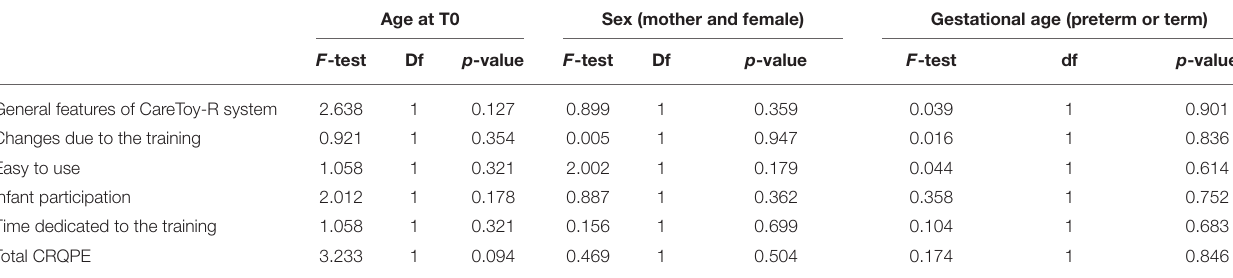
TABLE 7 | Infants’ characteristics and CRQPE answer questionnaire.